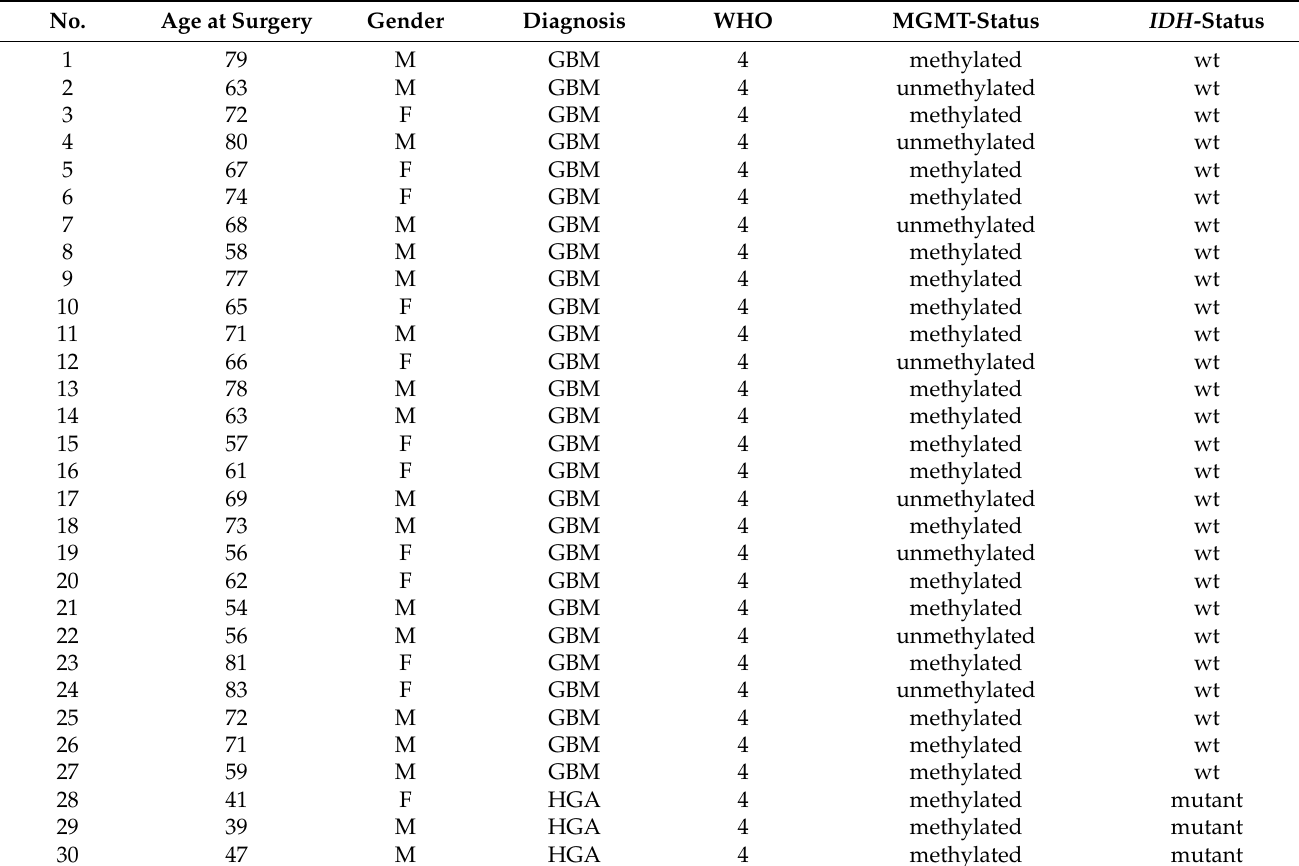
Table 1. Demographic and molecular data of glioma samples.